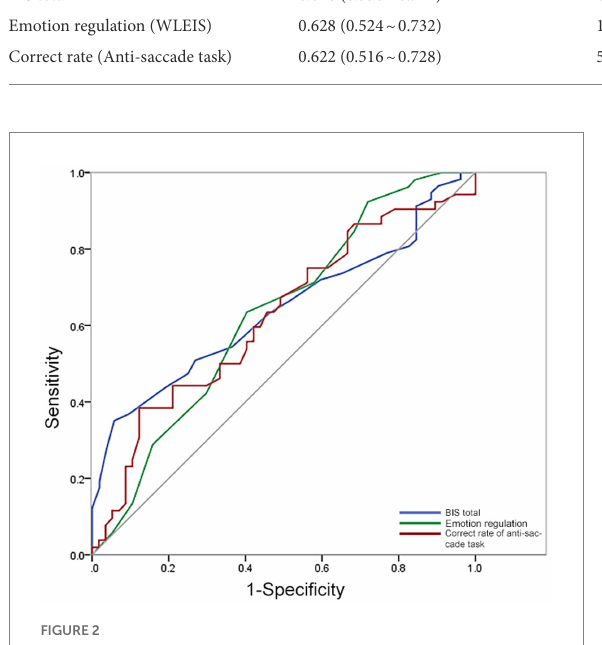
FIGURE 2 ROC of discriminating HIGD individuals from